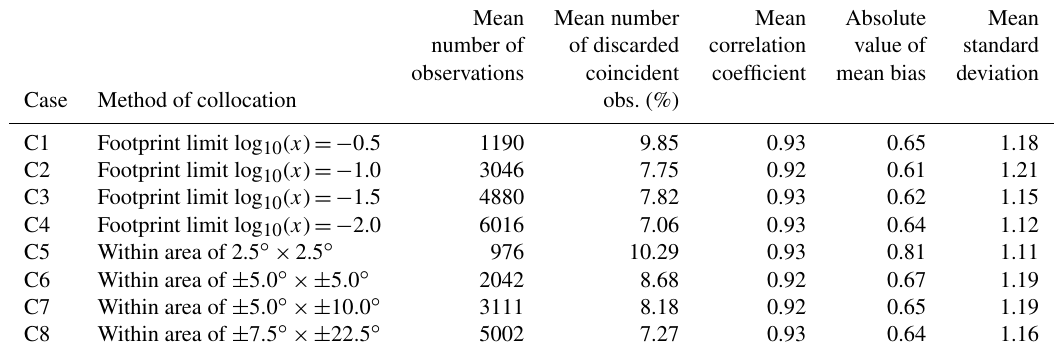
Table 4. Averaged results of different collocation methods implemented for XCO 2 from the GOSAT ACOS product calculated for 16 TCCON sites. Mean Mean number Mean Absolute Mean number of of discarded correlation value of standard observations